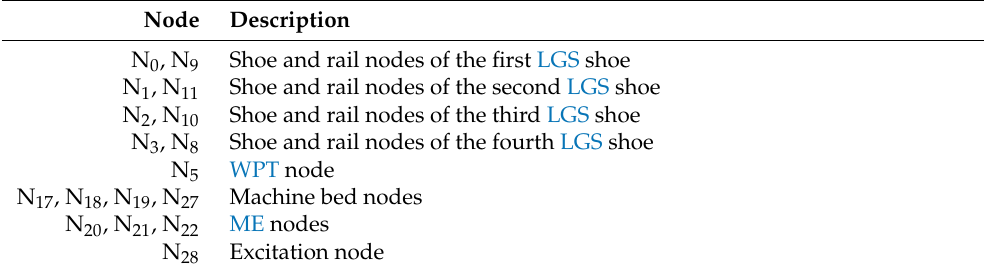
Table 5. Model nodes considered; the node locations are illustrated in Figure 7. Node Description N 0 , N 9